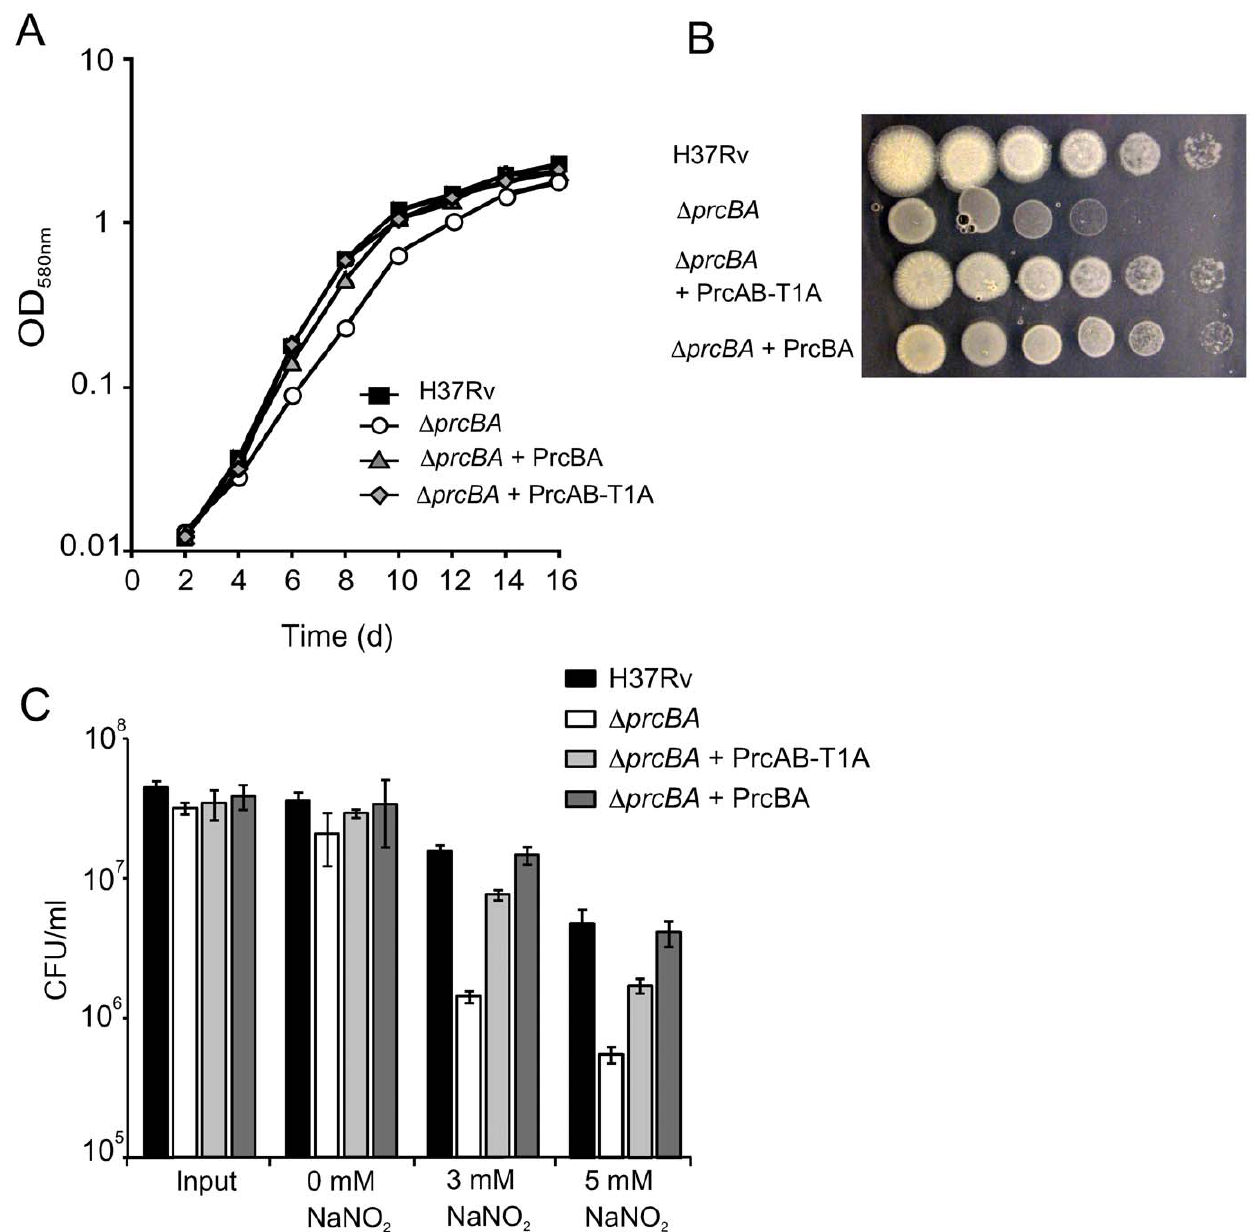
Figure 4. The active site mutant proteasome complements the growth defects and RNI hypersusceptibility of the proteasome KO. ( A ) Growth of H37Rv, D prcBA and the complemented strains in liquid culture. Strains were inoculated in 7H9 media and growth was followed by measuring OD 580 . ( B ). Growth of H37Rv, D prcBA and the complemented strains on agar plates. Serial dilutions of the indicated stains were spotted onto 7H11 agar plates and incubated for 3 weeks at 37 u C. ( C ) Susceptibility to reactive nitrogen intermediates. Colony forming units (CFU) of H37Rv, D prcBA and the complemented strains after three days exposure to 0 mM, 3 mM or 5 mM sodium nitrite at pH 5.5. Data are means 6 s.d. of triplicate cultures and representative of three independent